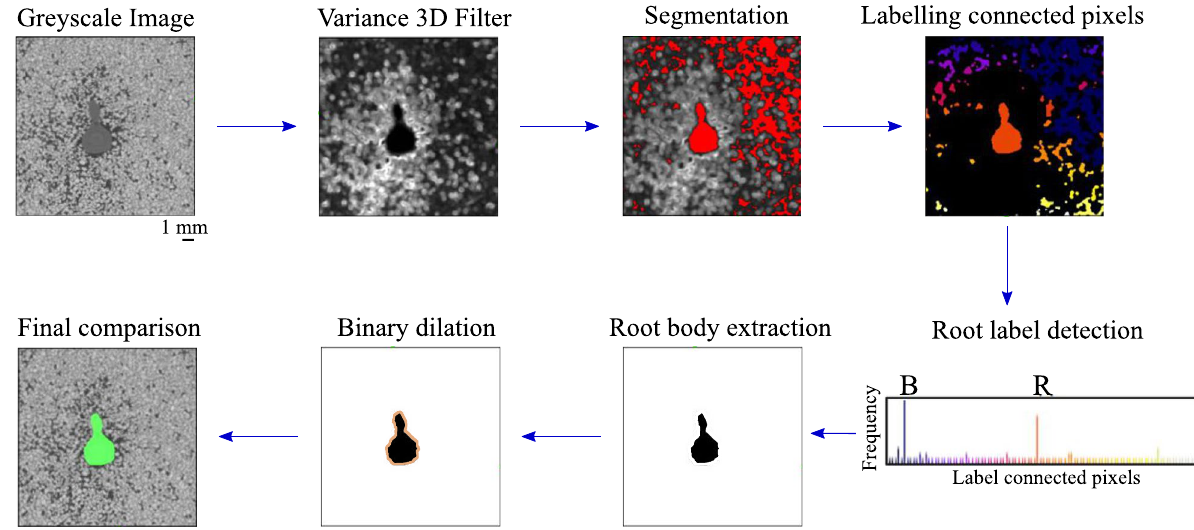
Figure 2. Steps of the image processing for the segmentation of the root system body from the greyscale image of the root-soil specimen. A 3D variance filter is applied to the original greyscale image, the output is segmented and each connected pixel is labelled. The frequency distribution of the new labelled image presents two main peaks corresponding to the background (B) and the root system (R). The segmentation is carried out in 3D, but a 2D cross section is displayed here for the sake of readability.